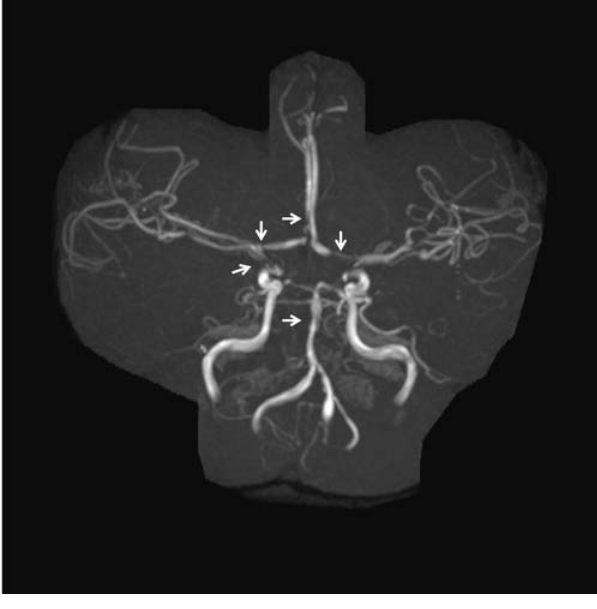
Figure 2. Magnetic resonance angiography (MRA) on day 26 of hospitalization (13 days after onset of headache). MRA shows regression of